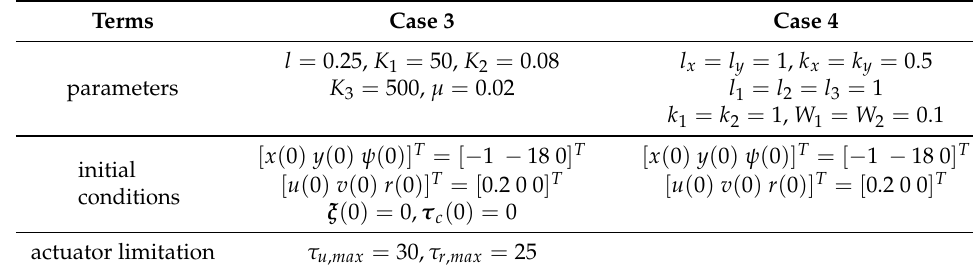
Table 2. Settings in Case 3 and Case 4.